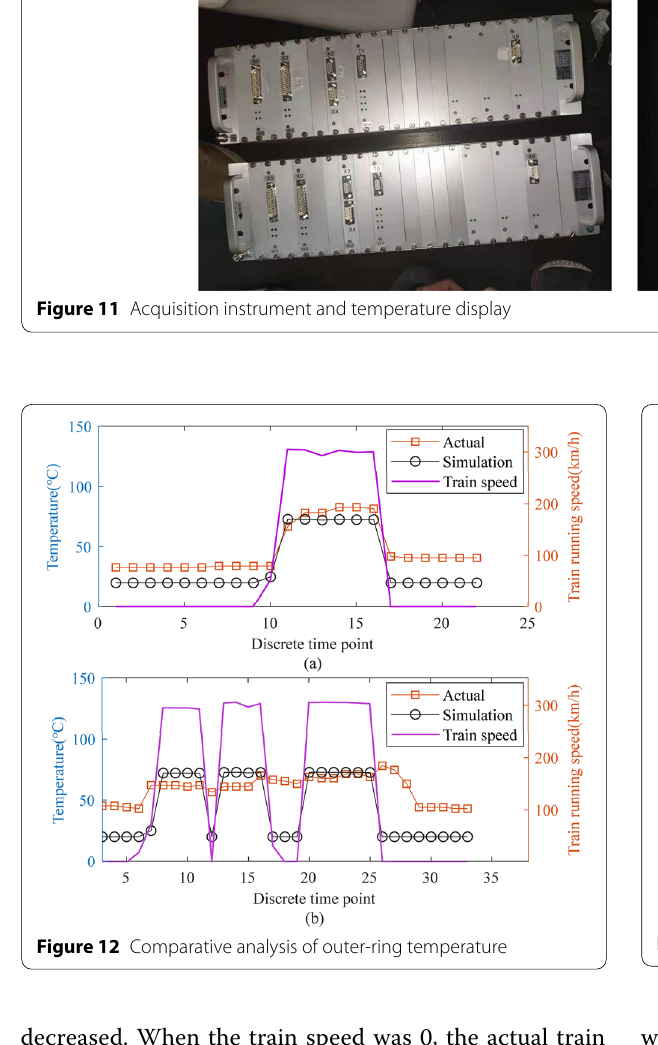
decreased. When the train speed was 0, the actual train bearing temperature slowly dropped to the ambient temperature. During this period, the actual temperature